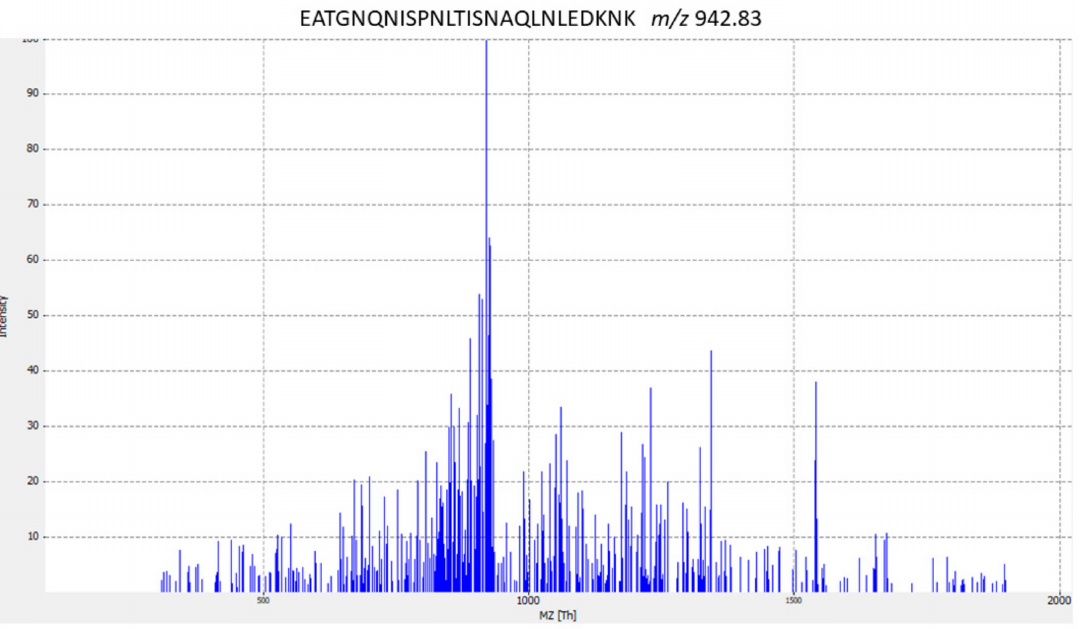
Figure 1. MS / MS spectrum for EATGNQNISPNLTISNAQLNLEDKNK S. dysgalactiae- specific peptide biomarker. The corresponding peptides were tested for specificity using the BLASTp